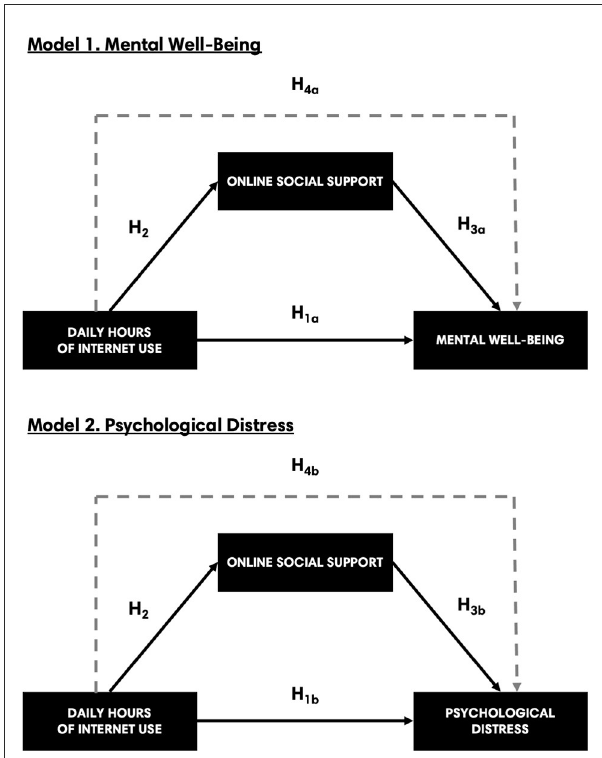
FIGURE1 Two simple mediation models: Model 1 presents the hypothesized indirect effect of DHIU on mental wellbeing through OSSS; Model 2 presents the hypothesized indirect effect of DHI on psychological distress through